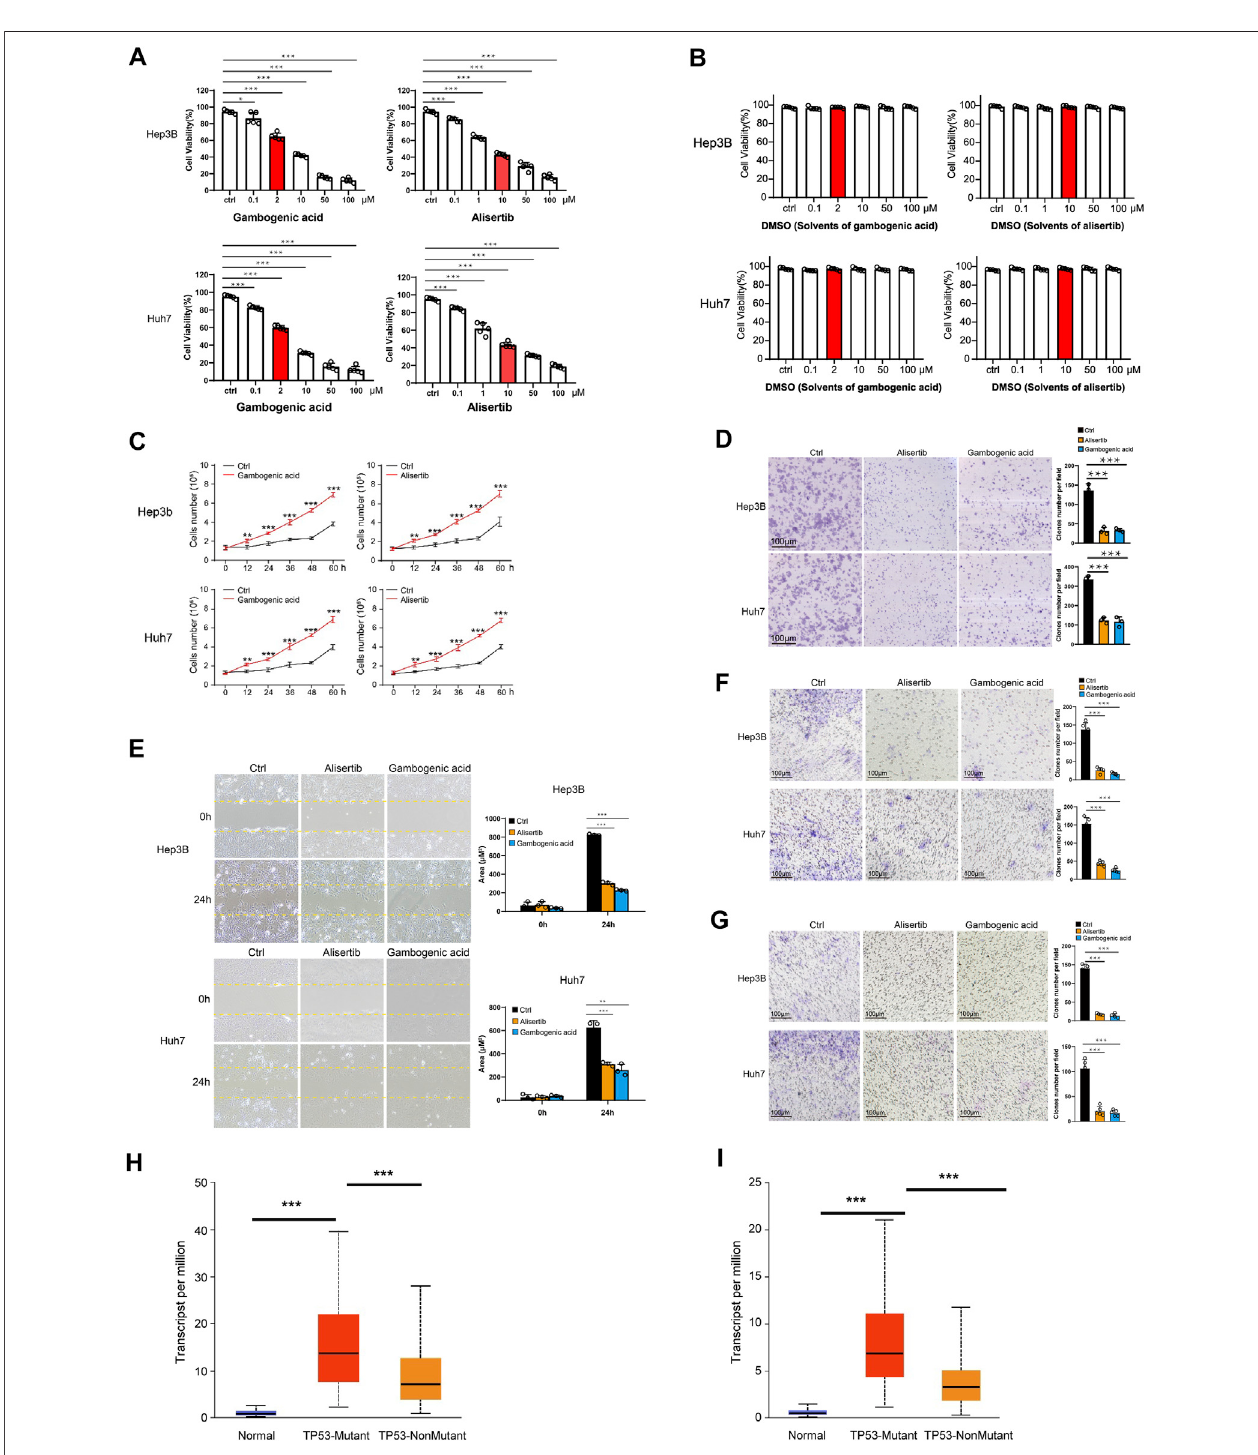
FIGURE7| Gambogenicacid(EZH2 inhibitor)and alisertib (AURKAinhibitor)inhibit HCC cellproliferation,migration,and invasion. (A) Hep3B and Huh7cells were treated with gambogenic acid (EZH2 inhibitor) or alisertib (AURKA inhibitor) at different concentrations (0 – 100 μ M) for 48 h, and cell viability was determined by Calcein- AM/PI staining assays. (B) Hep3B and Huh7 cells were treated with DMSO (solvents of gambogenic acid and alisertib) at different concentrations (0 – 100 μ M) for 48 h,